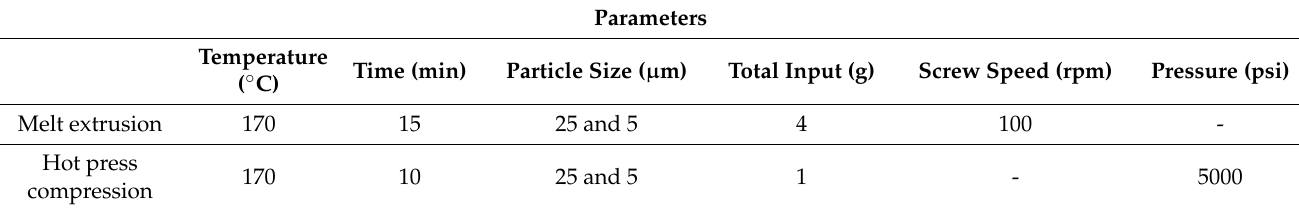
Table 2. Experimental conditions.